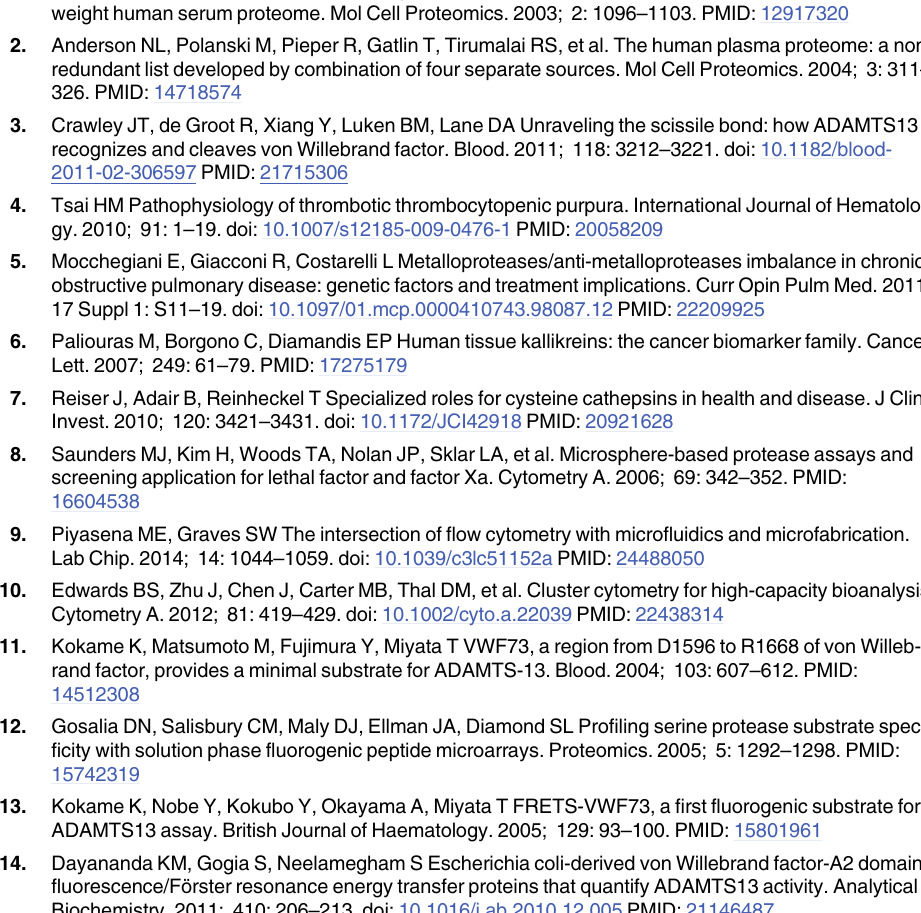
S3 Fig. Effect of bilirubin on the absolute fluorescence (AFU) in the Cerulean and Venus channels. Fluorescence is measured in two channels for the FRET assay: Ch.1: Ex420nm/ Em485nm; and Ch.2:Ex420nm/Em540nm. Bilirubin (Bil) augments fluorescence in Ch.1 due to its spectral properties and depresses this in Ch.2 due to absorbance in this range. These two features affect XS-VWF FRET ratio. Figure shows fluorescence in Ch.1 and Ch.2 for PPP (panel A ) and HIP (panel B ) at 60min upon titrating bilirubin in the presence or absence of XS-VWF.